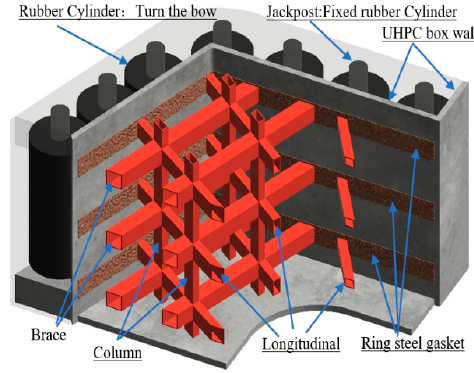
Figure 4. Internal structure of No.2 box.